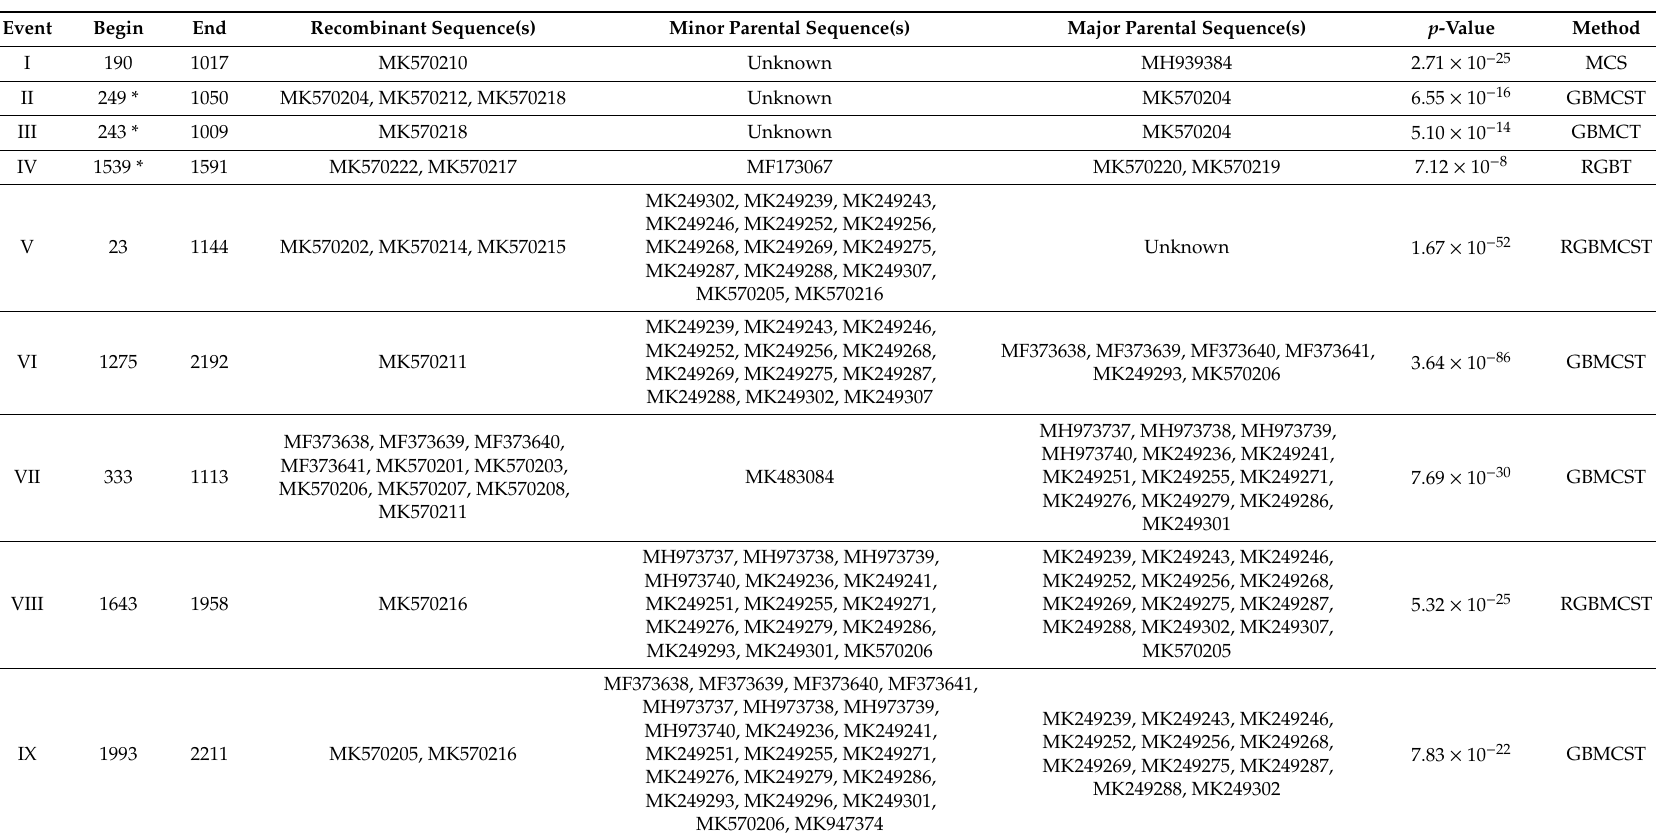
Table 3. Summary of recombination events identified in the genomes of gemycircularviruses and gemykibiviruses from this study. Major and minor parents indicate sequences (GenBank accession # provided) related to parental sequences that respectively donated the larger and smaller regions of the recombinant genome. For each event the recombination detection method with the most significant associated p -value is indicated in bold. Recombination detection methods: RDP (R),